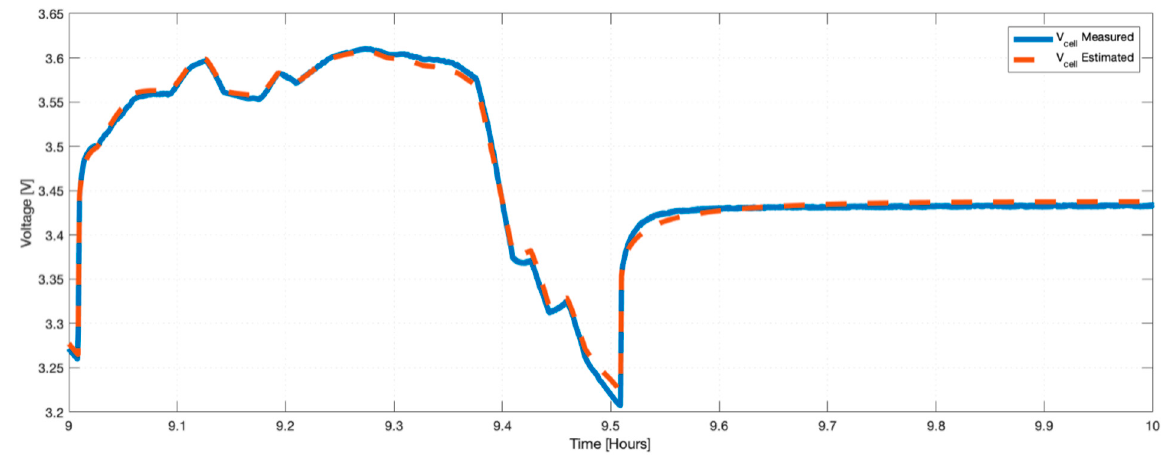
Figure 9. Cell I: Voltage measured versus estimated for one cycle (31 < SOC< 42).